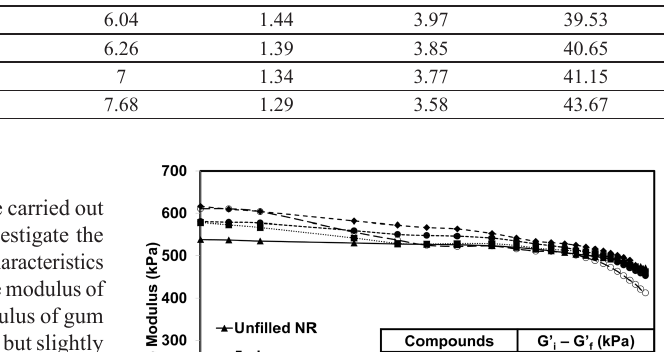
Table 4. Curing characteristics of the unfilled and sepiolite filled NR composites. Sepiolite content